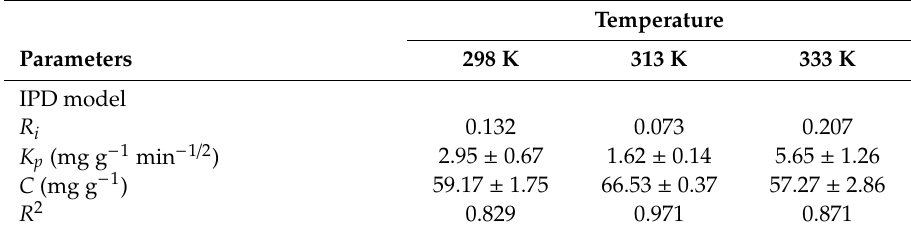
Table 2. Parameters of the intraparticle di ff usion (IPD) model for the MB adsorption on rGO, considering di ff erent temperatures.